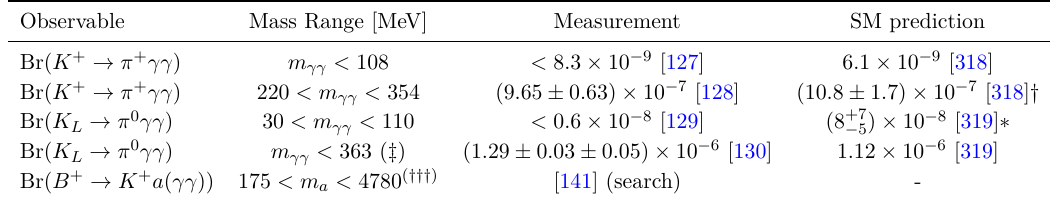
Table 4 . Observables with a photon pair in the final state. Bounds are at 90% CL. ( ‡ ) : cuts are applied to exclude the region around the π 0 pole ( 100 < m 160 MeV). ( ††† ) : cuts are applied to γγ < remove the regions around the η and η 0 masses ( 0 . 45 < m 0 . 63 GeV and 0 . 91 < m 1 . 01 GeV). a < a < ( † : calculated from results in the given reference. Error bars estimated from varying parameter ˆ c between its quoted errors.) ( ∗ : calculated from results in the given reference. Error bars estimated from varying parameter a between its quoted errors.). V